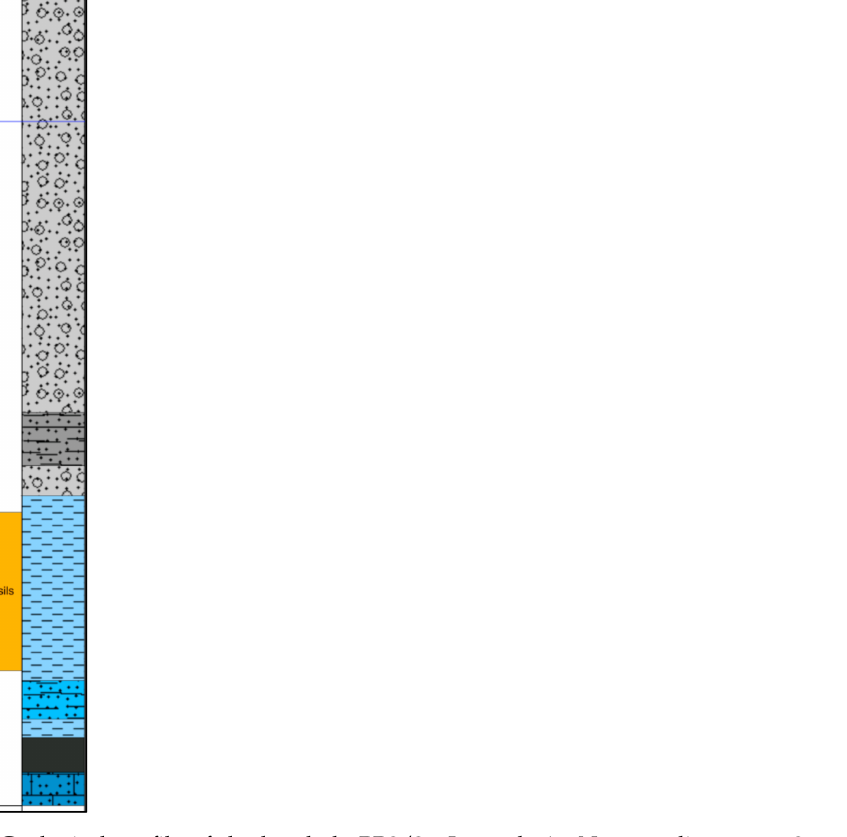
Figure 5. Geological profile of the borehole PR2/2. Legend: 1—Neogene limestone; 2—coal; 3—clayey marl; 4—marl, fossils; 5—Neogene; 6—conglomerate